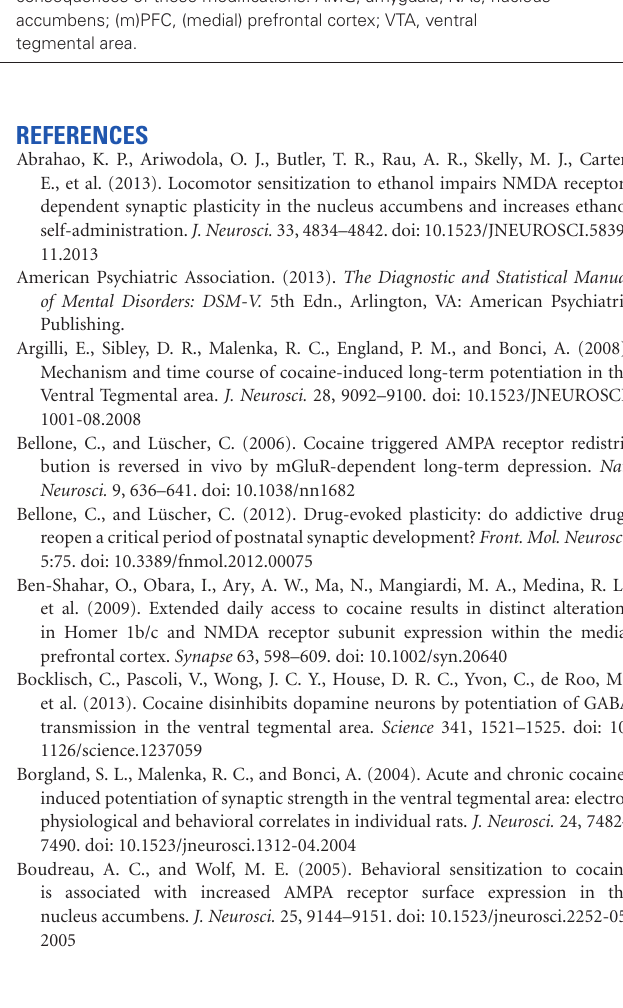
modifications that occur in these brain areas and the behavioral consequences of these modifications. AMG, amygdala; NAc, nucleus accumbens; (m)PFC, (medial) prefrontal cortex; VTA, ventral tegmental